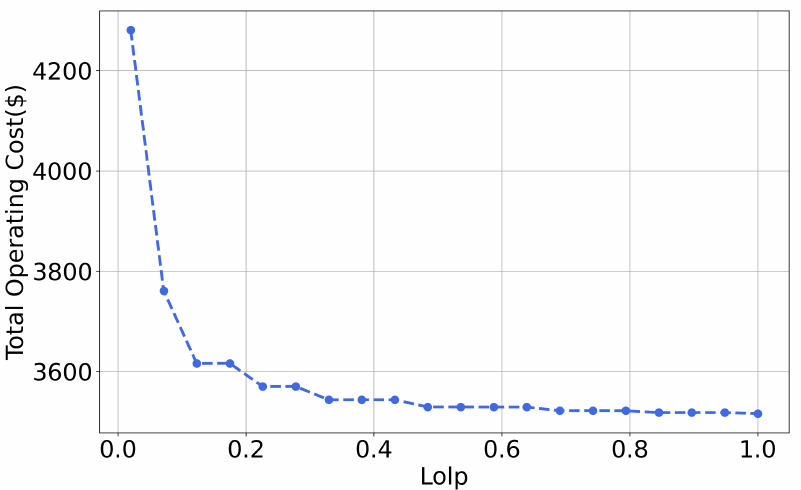
Figure 7. Operating costs under different Lolp